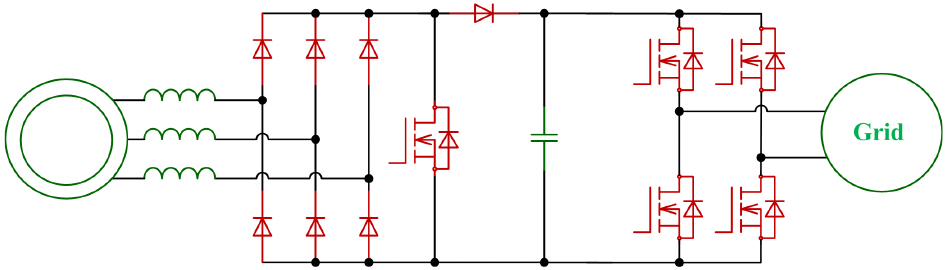
Figure 6. The three-phase single-switch boost converter wind generation system.